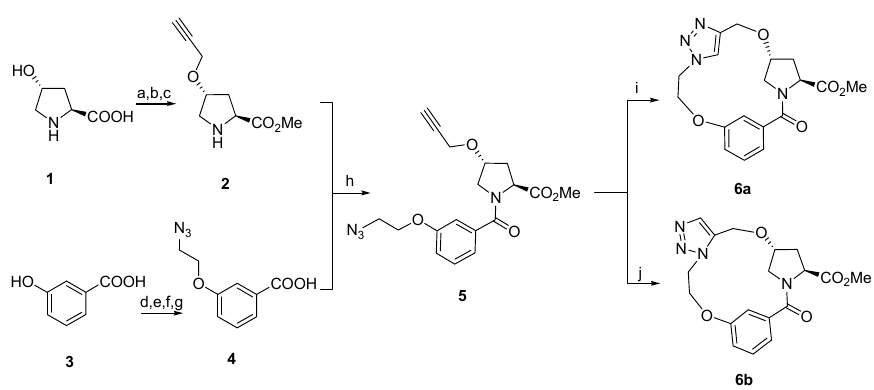
Scheme 1. Macrocyclization with azide-alkyne cycloaddition. Reagents and conditions : (a) (i) SOCl 2 ,